Question: What kind of plot is shown here?
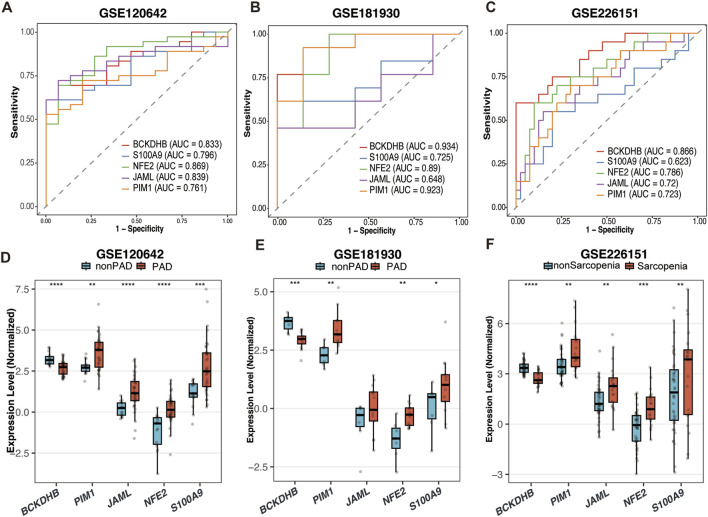
Answer: line